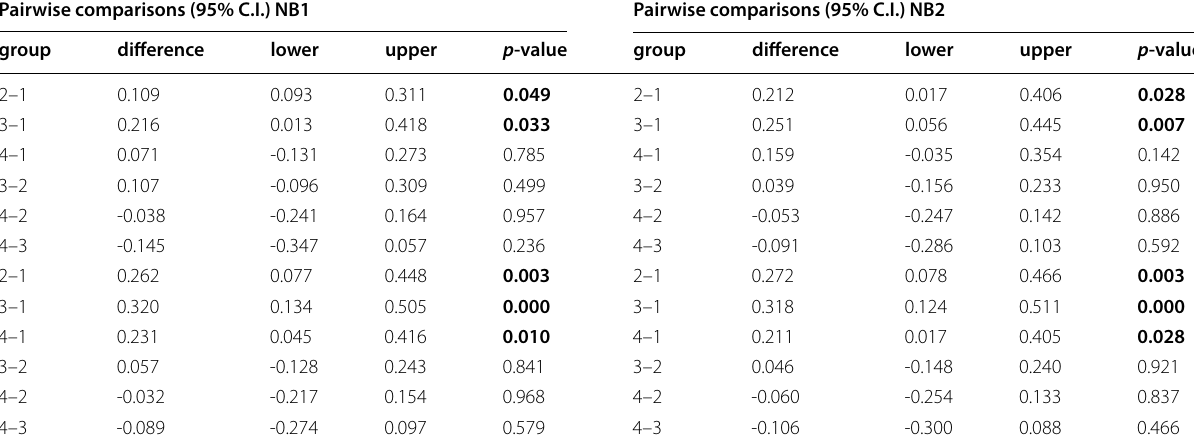
Table 3 Results of Tukey’s test on four sensors for multiple comparisons Pairwise comparisons (95% C.I.)